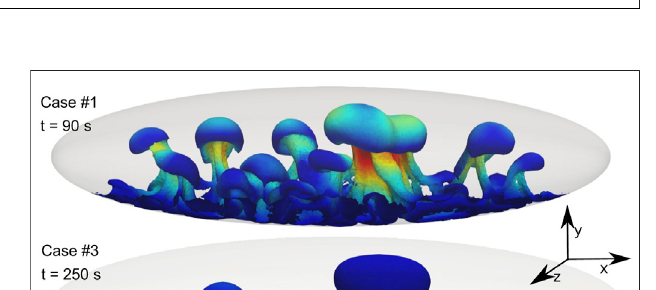
FIGURE 2 | Temporal evolution of isosurfaces of mass fraction Y (cid:2) 0.5.